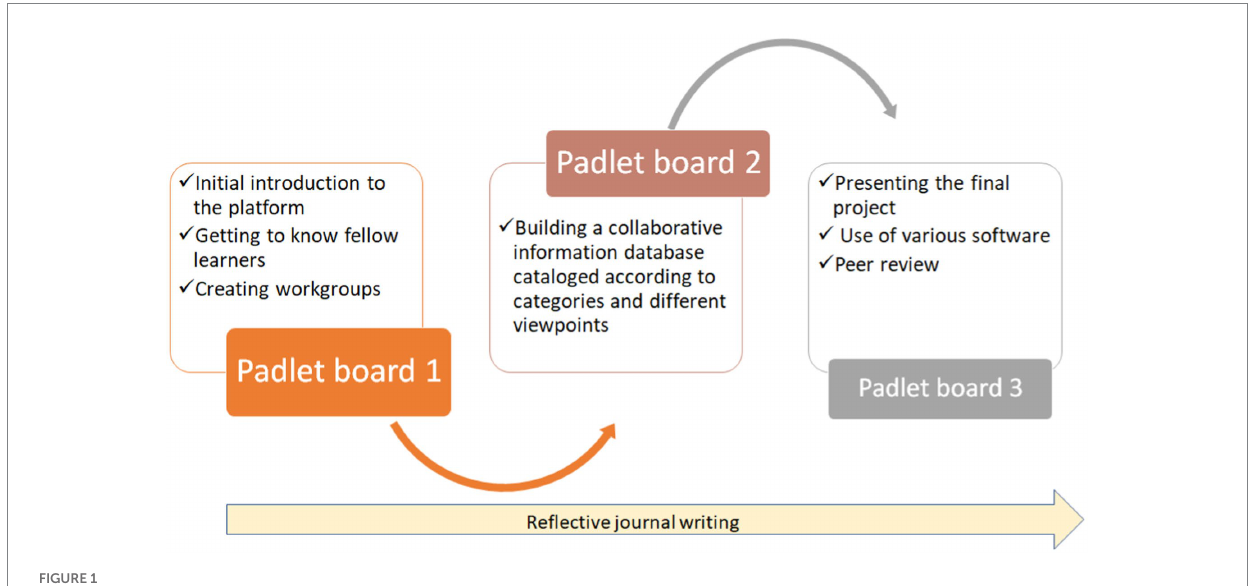
FIGURE 1 The procedure of the instructional